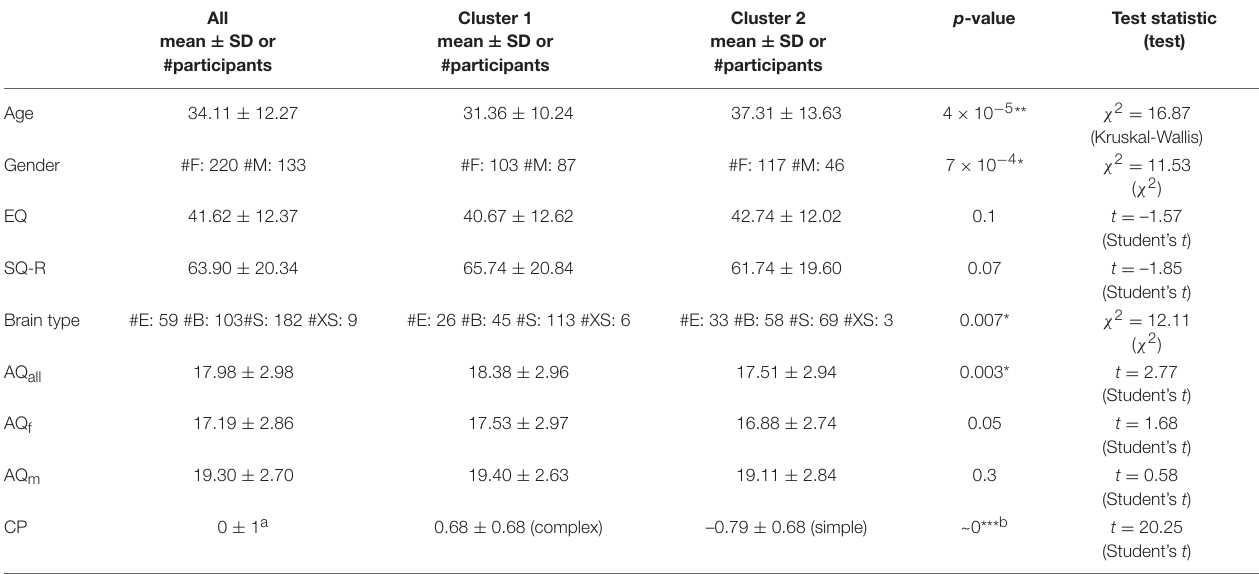
TABLE 3 | Characteristics of the participants assigned to the two